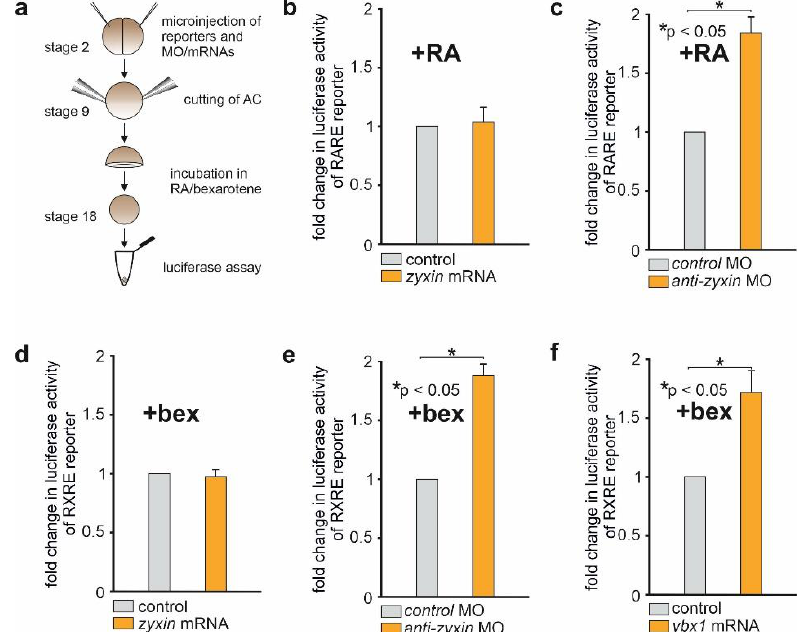
Figure 3. Effects of loss- and gain-of-function of Zyxin on γRXRE and RARE cis-regulatory elements in the luciferase reporter assay. ( a ) Experimental design. ( b ) Zyxin overexpression does not result in the activation of pGL3-3xRARE reporter in the presence of RA. ( c ) pGL3-3xRARE reporter activity induced by RA increased in AC with the downregulated zyxin . ( d ) Zyxin overexpression does not result in the activation of pGL3-2xγRXRE reporter in the presence of bexarotene. ( e ) pGL3-2xγRXRE reporter activity induced by bexarotene increased in AC with the downregulated Zyxin . ( f ) pGL3- 2x γ RXRE reporter activity increased in AC with the overexpressed ybx1 in the presence of bexarotene. Error bars indicate standard deviation. p -value was measured by Student’s t-test. The data presented are averaged from at least three independent experiments.